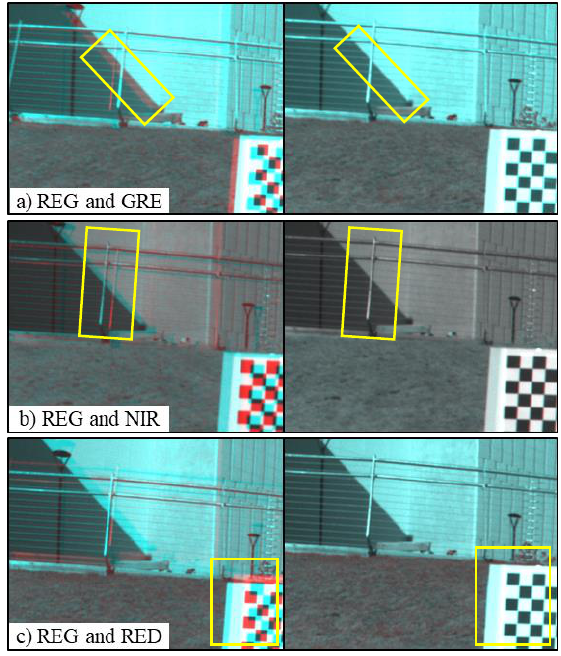
Figure 5. Images showing before (left) and after (right) co- registration between the REG band (in red) and the other three bands (in